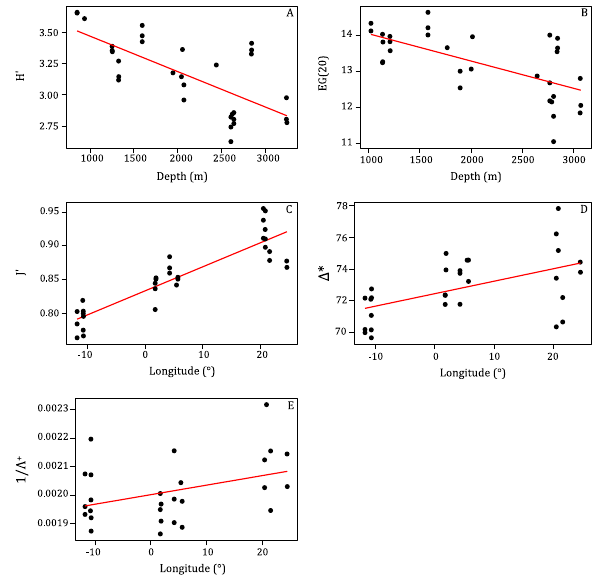
Fig. 2. Bathymetric and longitudinal trends in nematode diversity. For H 0 and EG(20), partial regression plots were constructed to Fig. 2. B thymetr c em t e vers ty. F r H’ EG 20), partial regression 924 show the isolated effect of water depth, while the other plots show plots were constructed to show the isolated effect of water depth, while the other plots show marginal 925 regress s. H’: Sh -Wiener diversity, EG(20): expected genus richness for a sample of 20 926 marginal regressions. H 0 : Shannon–Wiener diversity, EG(20): ex- v u ls, J’: P el u’s eve ess, Δ*: ver ge t x m c st ct ess se pected genus richness for a sample of 20 individuals, J 0 : Pielou’s evenness, 1 ∗ : average taxonomic distinctness based on quantitative data, 1/ 3 + : taxonomic evenness. The goodness of fit of these re- gressions is indicated in Table